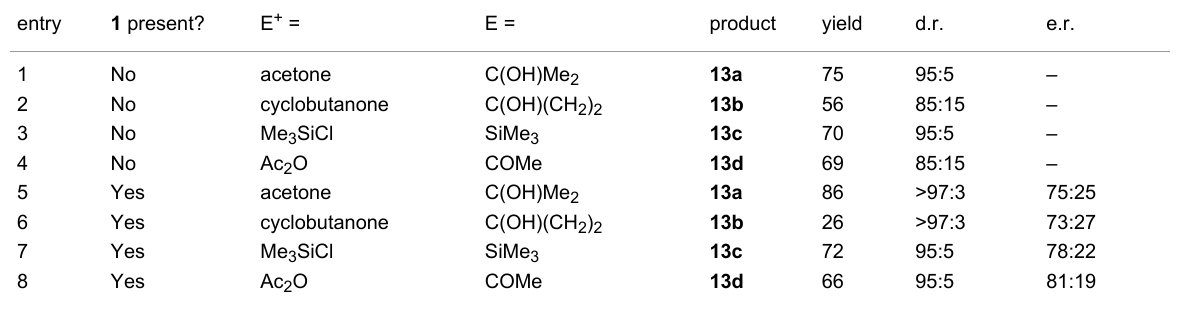
Table 1: Yields and selectivities in the metallation/quench of 11 . entry